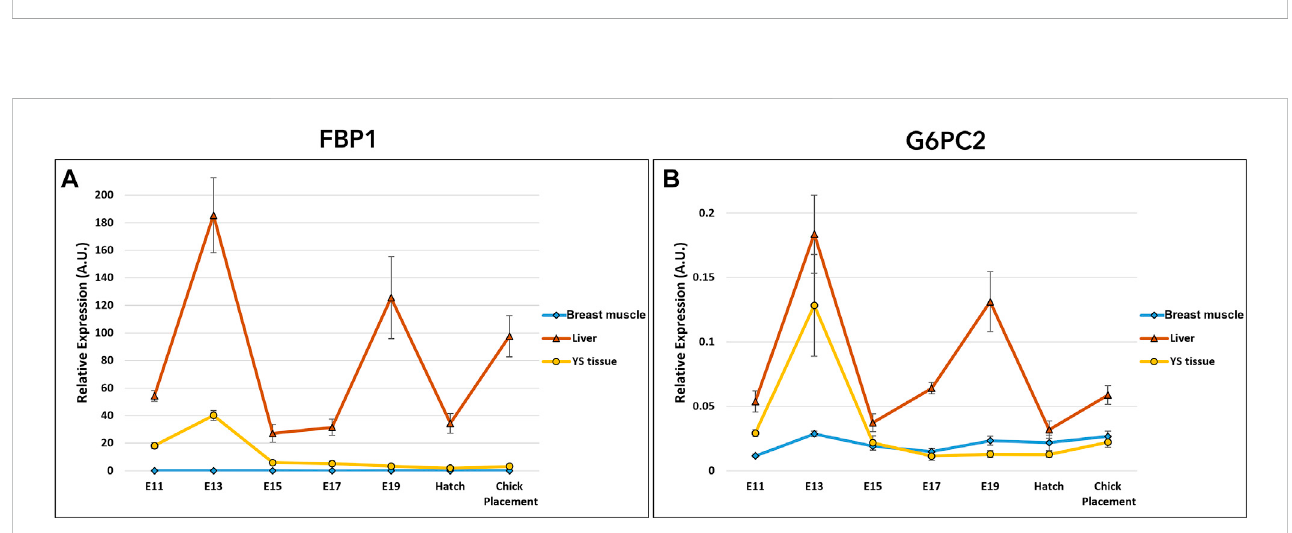
FIGURE 5 Dynamic expression of genes involved in gluconeogenesis (A) Fructose-1,6-bisphosphatase 1 (FBP1), regulatory enzyme, catalyzes the hydrolysis of fructose 1,6-bisphosphate to fructose 6-phosphate (B) Glucose-6- phosphatase 2 (G6PC2), catalyzes the hydrolysis of glucose-6-phosphate, allowing the release of glucose into the bloodstream. Expression analysis of FBP1 and G6PC2 by a two-way ANOVA followed by Tukey ’ s HSD test revealed signi fi cant interactions between the effects of age and tissue. ( p < 0.05), n = 6 per